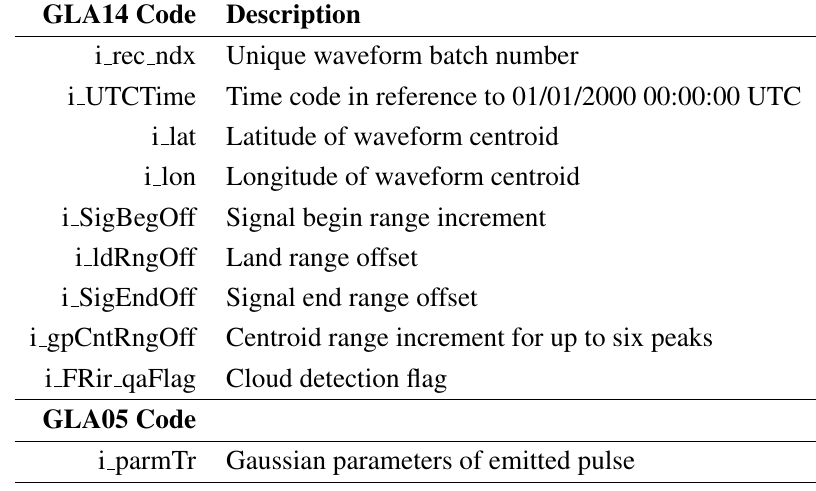
Table 1. Summary of the GLAS ancillary data parameters used in this